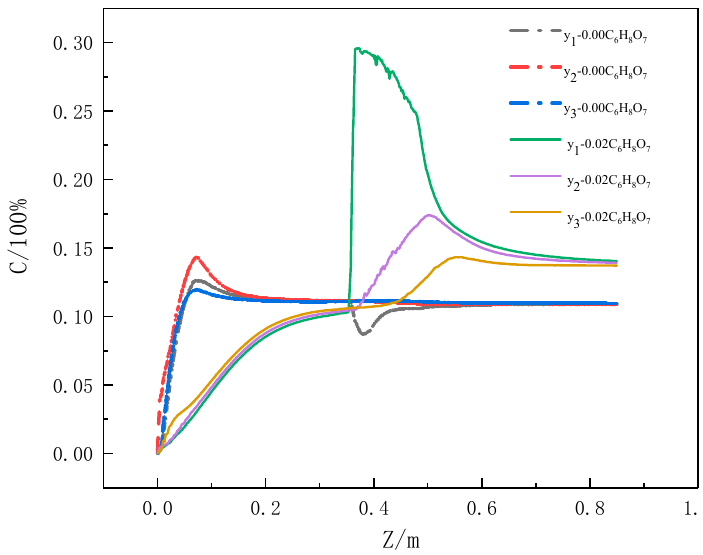
Figure 7. CO 2 concentration distribution graph of the monitoring lines.